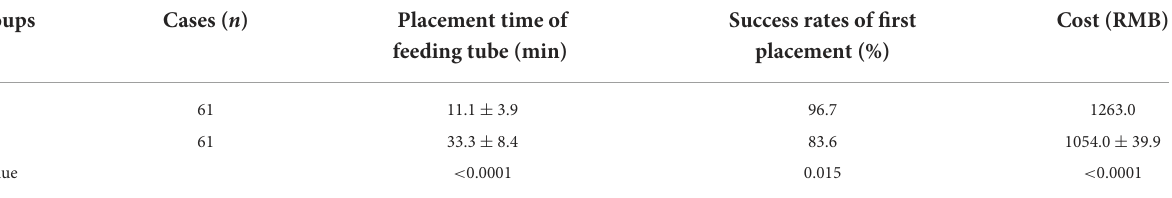
TABLE 2 The comparison of time, success rate and cost of feeding tube placement.